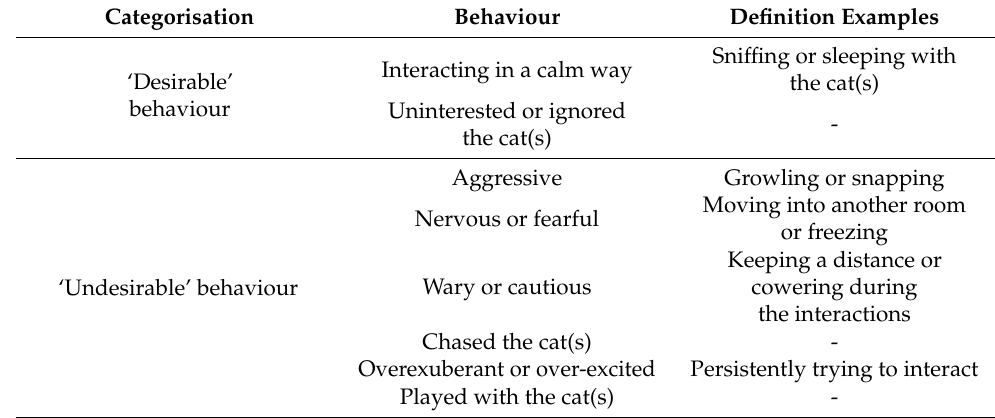
Table 1. Definition and categorization of owner-reported observed puppy behaviour following introduction to existing household cat(s).